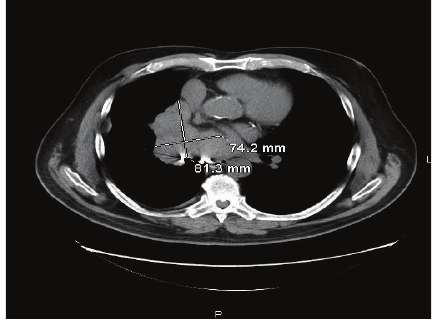
Figure 1: CT Scan of chest showing right hilar mass.